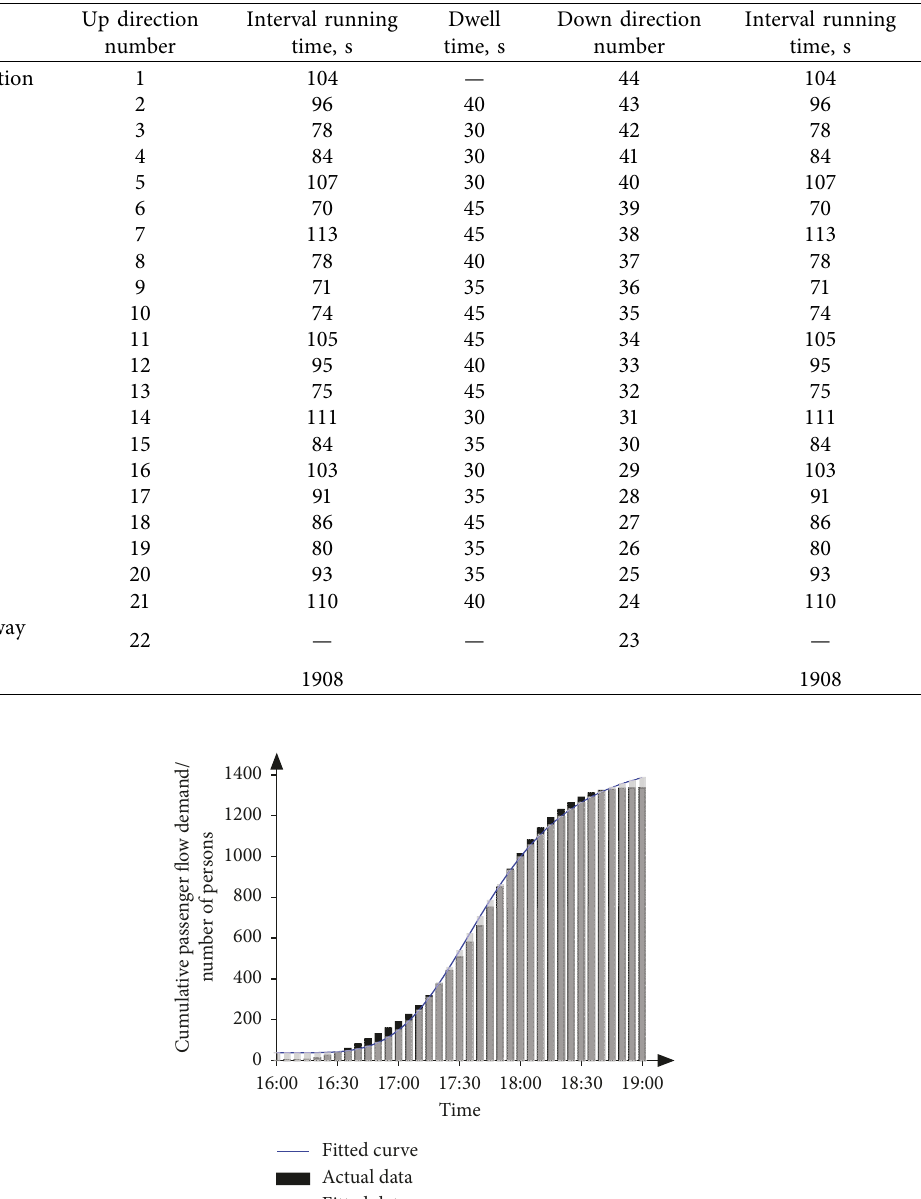
Table 2: Interstation running time and dwell time.